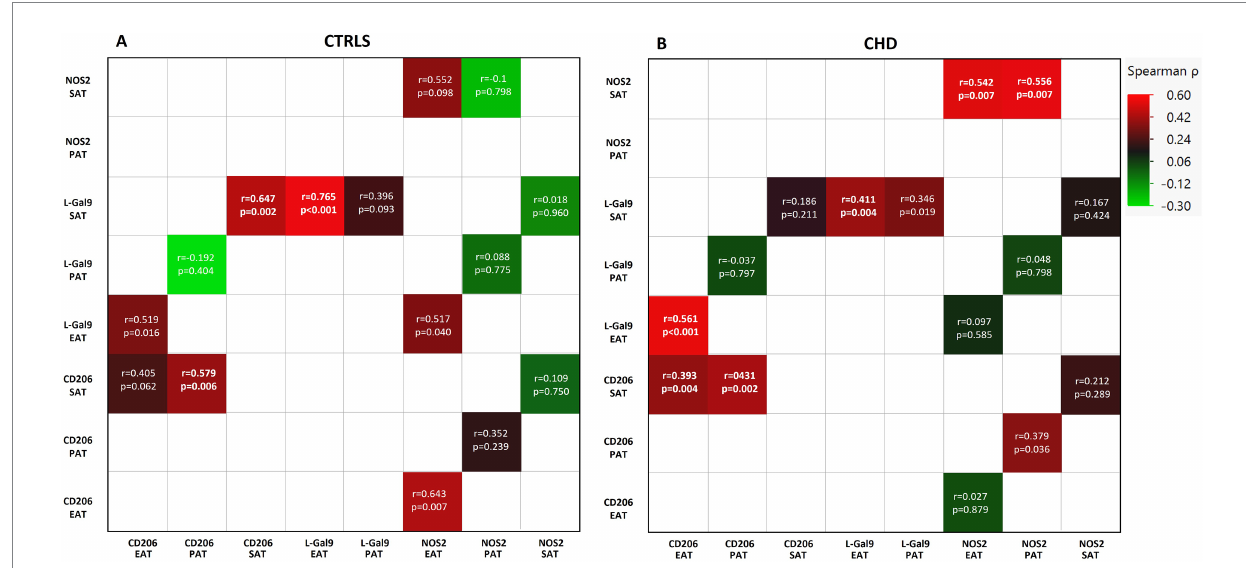
FIGURE 2 Correlations between the expression of L-Gal9, CD206, and NOS2 in SAT, PAT, and EAT compartments in CTRLs (A) and CHD patients (B) . Correlations are reported as heatmap following Spearman ρ analyses, and those still significant after Bonferroni correction are marked in